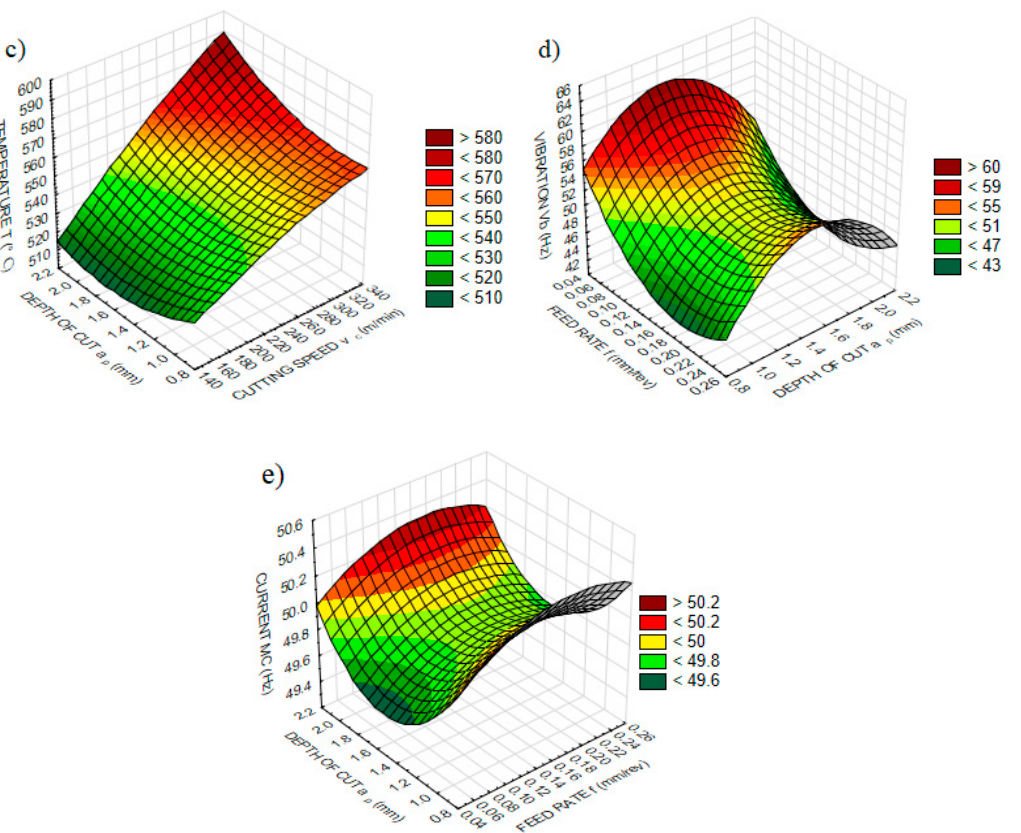
Figure 4. The variation of sensorial data according to effective parameters: ( a ) cutting force F (N), ( b ) acoustic emission AE (kHz), ( c ) temperature T (°C), ( d ) vibration Vb (Hz), ( e ) current MC (Hz).